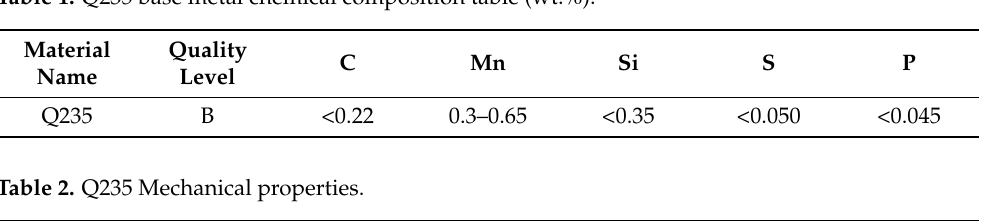
Table 1. Q235 base metal chemical composition table (wt.%).